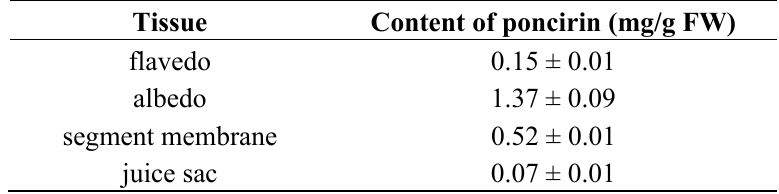
Table 1. Content of the poncirin in four tissues of Ougan